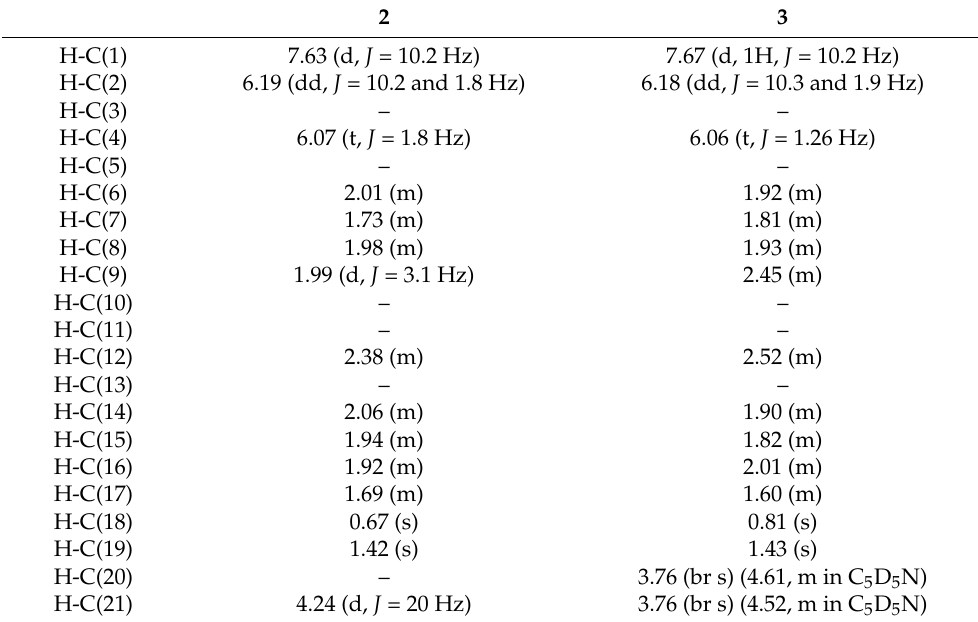
Table 2. 1 H-NMR data of 2 and 3 at 400 MHz in CDCl 3 , δ in ppm, and J in Hz.